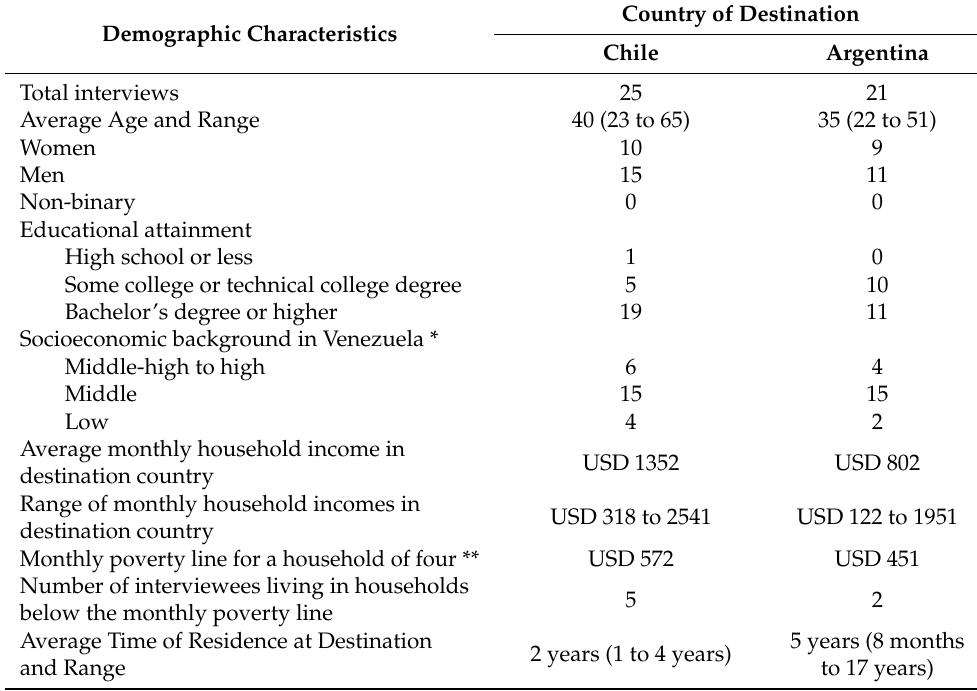
Table 1. Demographic characteristics of interviewees in Chile and Argentina (first interview). Demographic